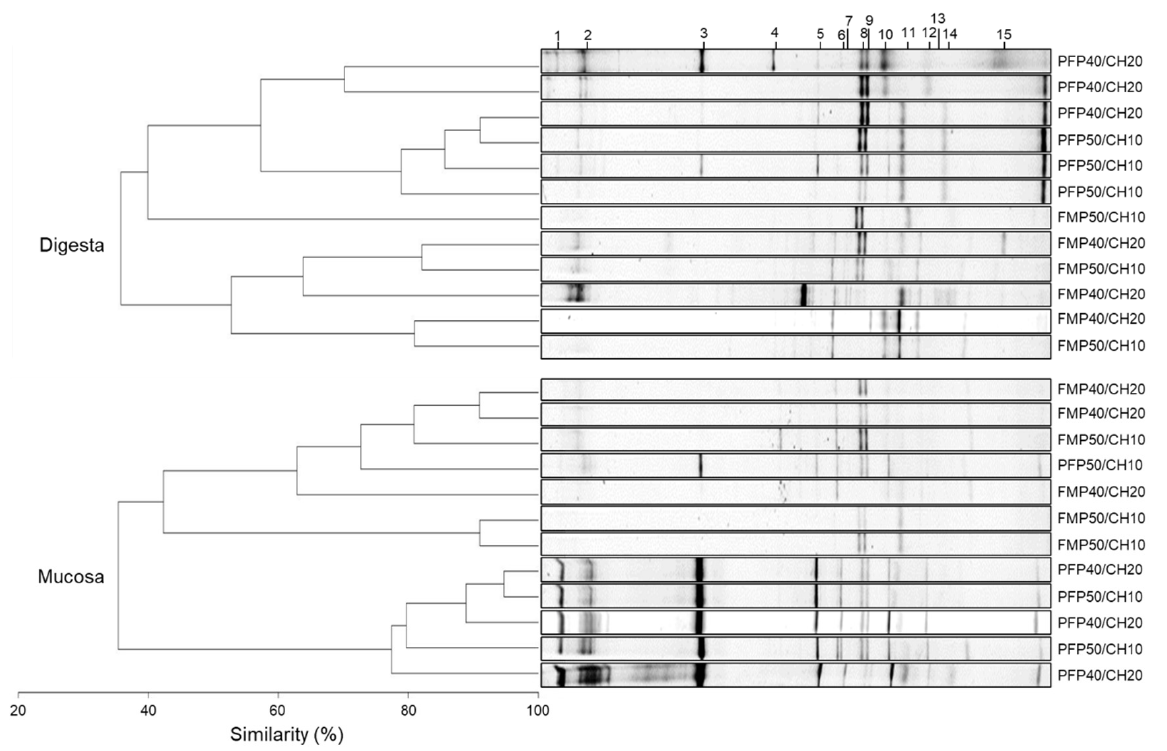
Figure 4. Dendrogram and PCR-DGGE fingerprints of the microbiota found in digesta and mucosa samples recovered from the gut of gilthead seabream fed the experimental diets. Numbers (1–15) on top of the figure correspond to the gel bands sequenced to identify the corresponding bacterial species, described on Table 5. Table 4. Ecological parameters obtained from PCR- DGGE fingerprints of gut microbiota of gilthead seabream fed the experimental diets.